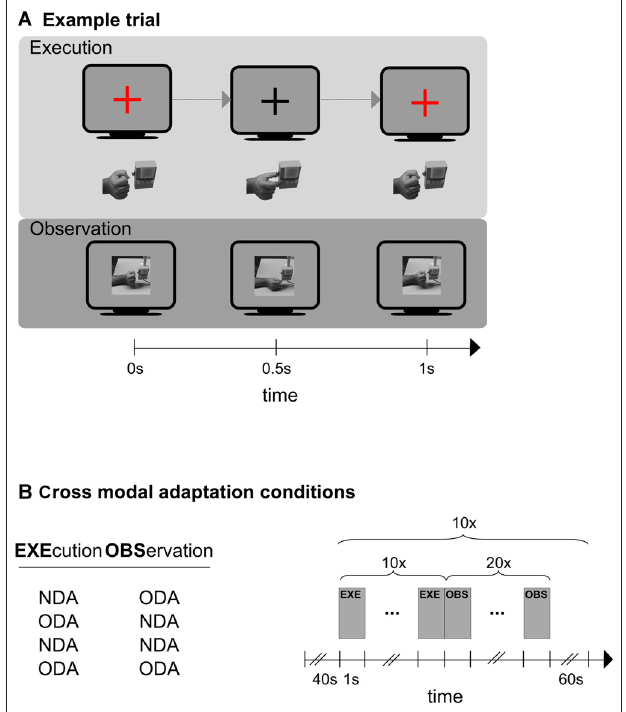
FIGURE 1 | Schematic representations of an experimental trial (A), and the experimental design of the cross modal session (B). (A) Shown is one trial of the execution phase (top) and one trial of the observation phase (bottom). In the execution condition (top) participants synchronized their hand action (hand below monitor symbol) to the color change of a fixation cross (monitor symbol). Only the object-directed action (ODA) action is shown here. The color of the fixation cross was blue in case of an non-object-directed (NDA) action (not shown here). In the observation condition (bottom) participants observed ODA and NDA actions that were presented on the screen. Only the NDA condition is shown here. An example for an ODA is shown at the top and for the NDA at the bottom. (B) Left: the four cross-modal adaptation conditions. Action execution always preceded action observation. Right: schematic representation of the outline that each of the four adaptation conditions followed. A 40 s baseline preceded an experimental block in which participants first executed (EXE) an action (10 times) and then immediately afterwards observed (OBS) a action (20 times). The block was repeated 10 times. Any two blocks were separated by an inter-block-interval (IBI) of 60